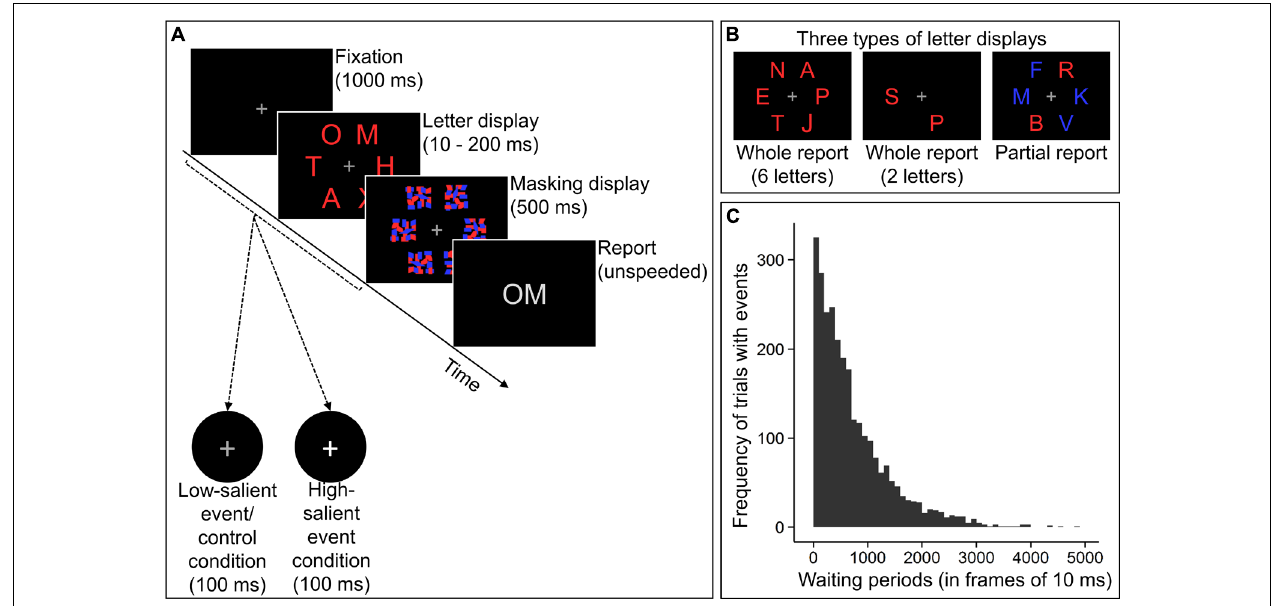
not in the control condition. Luminance increases were greater in the high-salient event compared to the other two conditions. (B) Letter displays could be of three different types, enabling the estimation of attentional components (Vangkilde etal., 2011). (C) Across each condition, waiting periods to events approximated the non-aging geometric